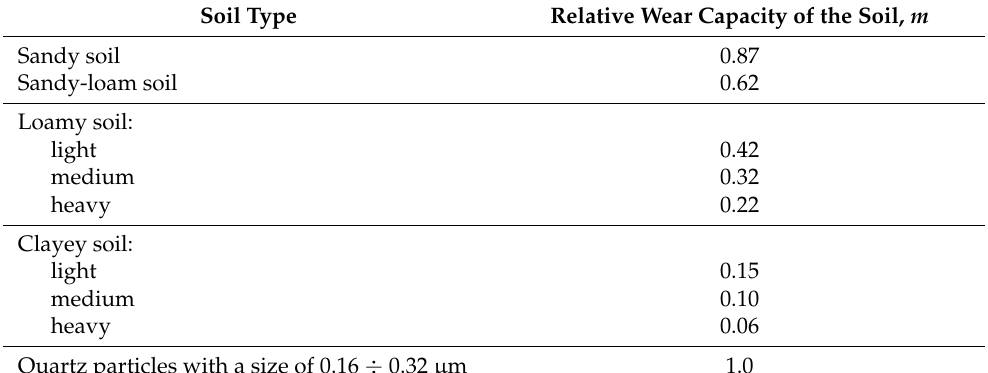
Table 1. Relative wear capacity of soils